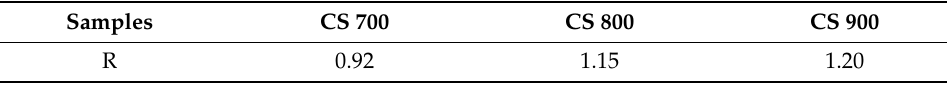
Table 2. Different intensity ratios of the